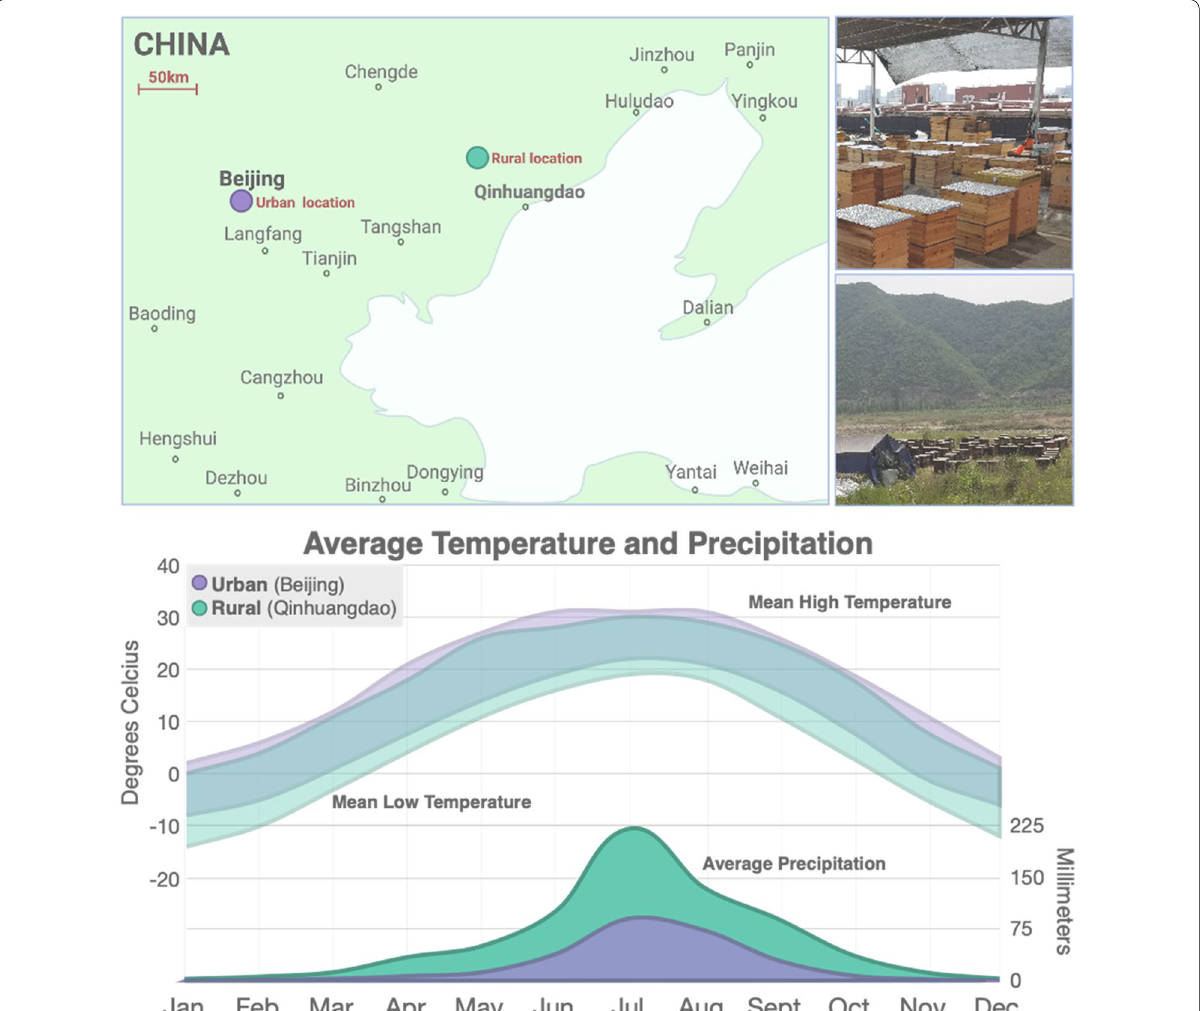
Fig. 1 Sampling locations of ITBs and RJBs from China. Honey bees were sampled from six RJB and six ITB hives located on the rooftop of the Chinese Academy of Agricultural Sciences in Beijing, China (i.e. urban, pictured in top right) and from six RJB hives located in Zhuzhangzi township, Qinglong County, Qinhuangdao, Hebei province, China (i.e. rural, pictured in bottom left). The mean monthly temperature high and low and mean amount of precipitation for each location are shown in the bottom panel. The rural location is cooler in terms of average monthly temperature high and low and also receives higher precipitation, particularly during the summer when bees were sampled (June 2018). The graph was created based on climate data from https:// www. timea nddate.